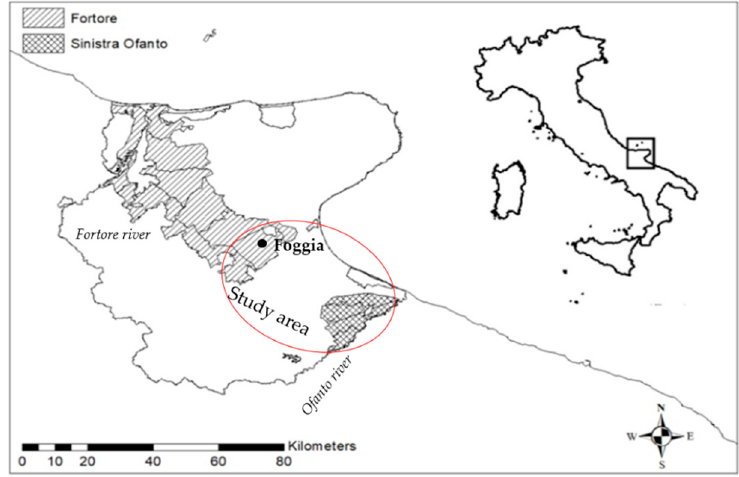
Figure 1. Study area. Source: Adapted with permission from Giannoccaro [24].